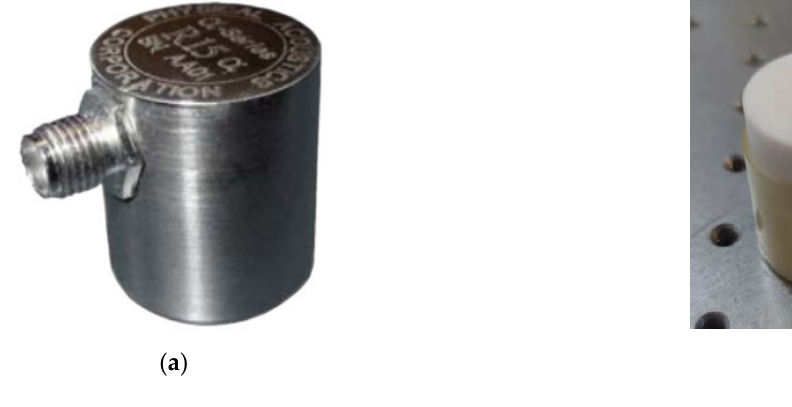
Figure 9. ( a ) Sound source PZT; ( b ) optical fiber ultrasonic sensor.